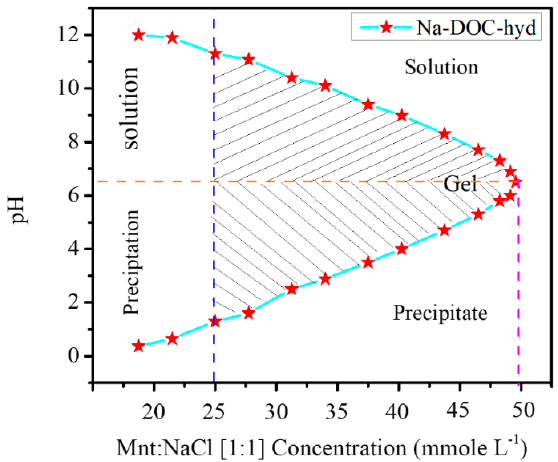
Figure 1. Optimizing the concentration of Mnt (mannitol) and NaCl for in situ gelation of sodium deoxycholate (Na-DOC) in the tumor extracellular microenvironment (pH 6.5) (Mnt: (1:1 mmole L − 1 concentration ratios of Mnt: NaCl were used).